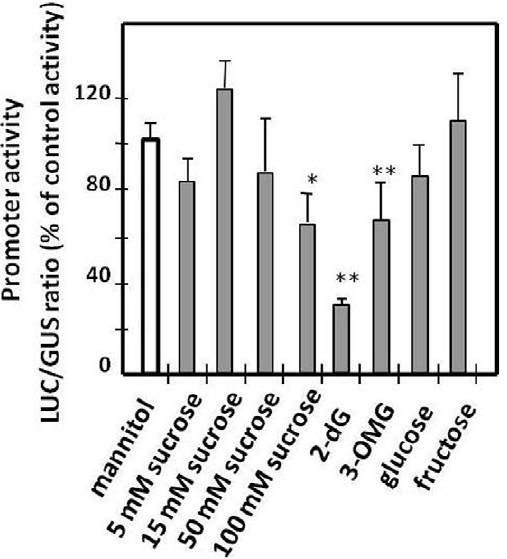
Figure 7. Influence of sugars on SlPPC2 promoter activity. Fruit slices from 8 daa fruit («WVa 106» cherry) were transformed by biolistic with a 35S:GUS plasmid co-delivered with SlPPC2 promoter:LUC fusion pPPC2pro1:LUC plasmid and incubated for 20 h on CPW4 medium supplemented with sucrose concentrations ranging from 5 mM to 100 mM as indicated, 3-O methylglucose (3-OMG, 50 mM), 2-deox- yglucose (2-dG, 50 mM), glucose (50 mM) or fructose (50 mM). Control was CPW4 medium supplemented with mannitol (50 mM). Data were normalized using the 35S:GUS construct as internal standard and are expressed as % of the control. The mean values and SE of 12 independent transformations are shown. * indicates a significant statistical difference using a Student’s t -test (*: P , 0.05; **: P , 0.001).